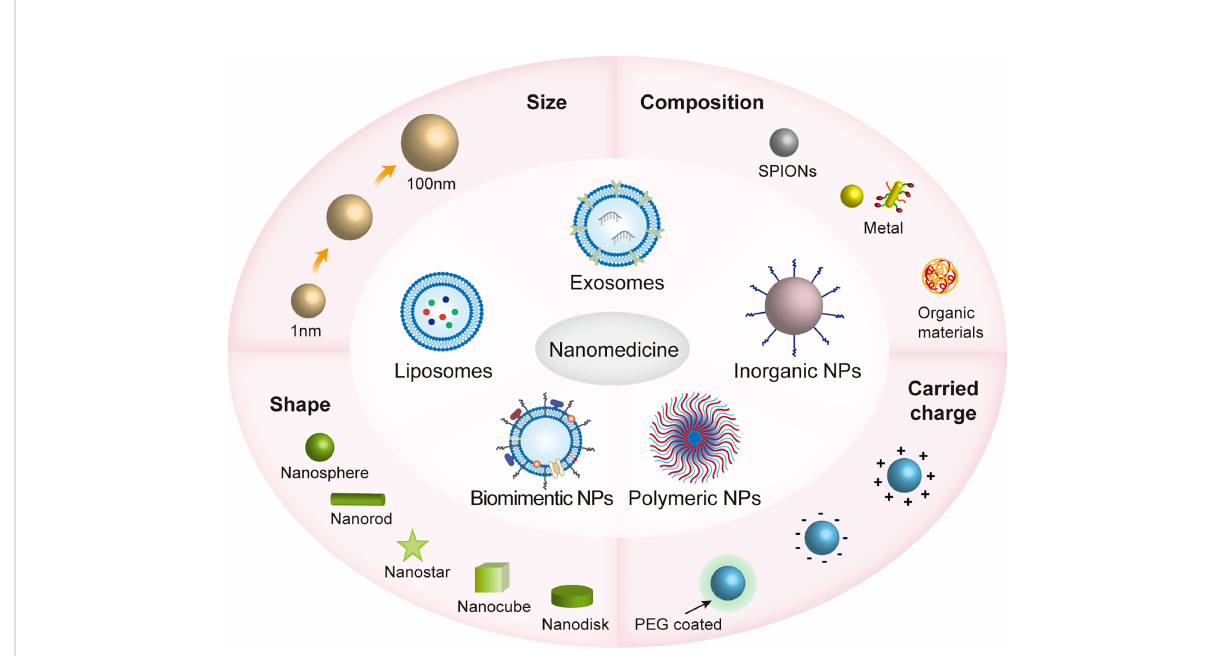
FIGURE 1 The various properties of nanomaterials in nanomedicines. Nanomaterials are subdivided into polymorphic nanoparticles (NPs), liposomes, biomimetic NPs, inorganic NPs, and cell-derived exosomes, which range in size from approximately 1 to 100 nm and have different shapes, including nanospheres, nanorods, nanostars, nanocubes, nanodisks, etc.; consist of different materials, including SPIONs, metallic fabrics, and organic materials; and are both positively/negatively charged on the surface or coated by PEG. These physicochemical properties in fl uence how ef fi ciently nanomaterials enter the cell and the mode of action that affects cellular activity. The size and shape of the nanomaterial can determine the way it enters the cell, such as clathrin-mediated endocytosis (120nm), and clathrin- and caveolae-independent endocytosis (~60nm) (51).. The surface charge of nanoparticles affects the cell membrane state, for example, the binding of negatively charged nanoparticles to cellular lipid bilayers causes local gelation, while the binding of positively charged nanoparticles to cellular lipid bilayers causes the fl ow of phospholipid bilayers (52). Polyethylene glycolization reduces premature removal of NPs from the cycle